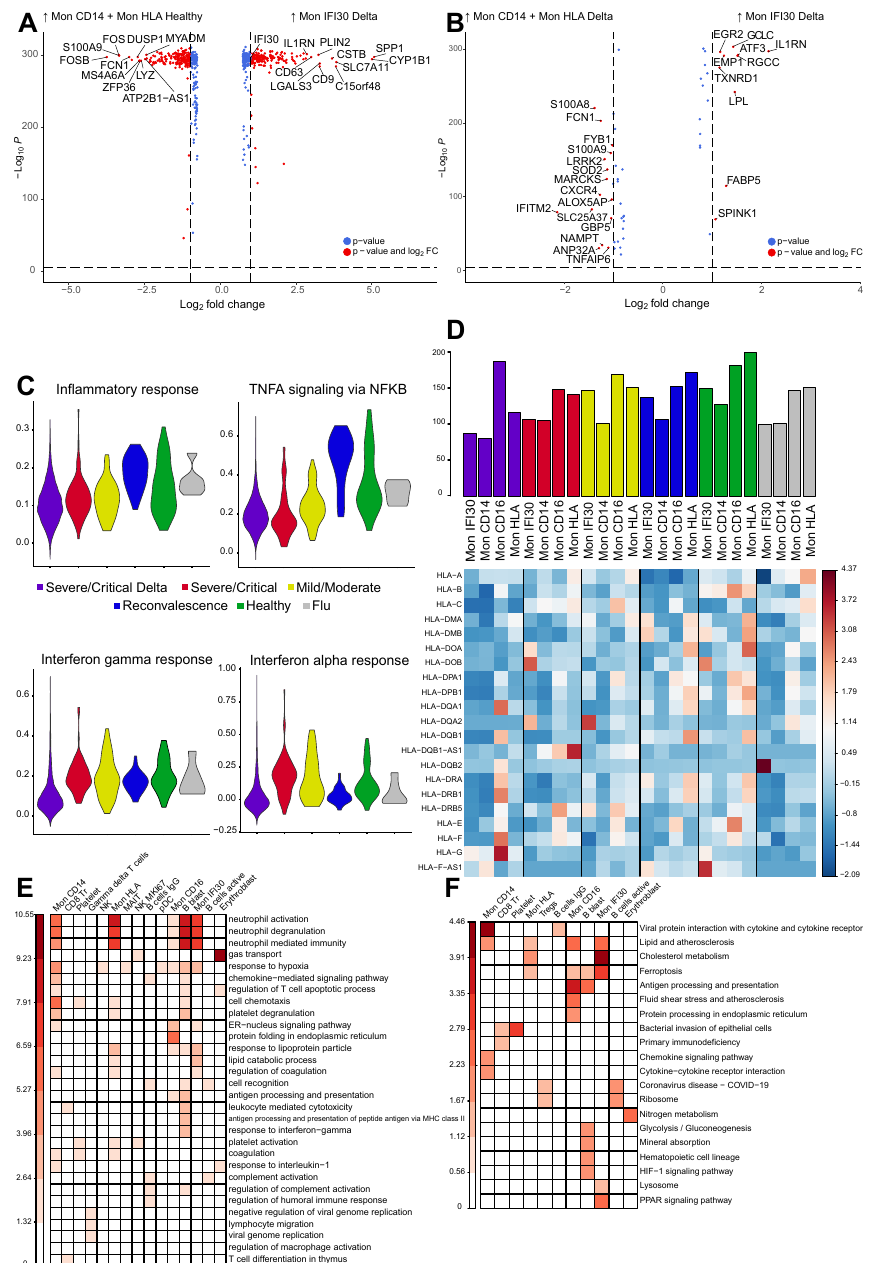
Figure 3. ( A ) Volcano plot showing gene expression changes between Mon IFI30 from severe Delta samples contrasted with Mon CD14 and Mon HLA from healthy groups because Mon IFI30 is enriched only in the severe Delta COVID-19. Only top significant markers with absolute logFC > 0.75 are highlighted. ( B ) Volcano plot showing gene expression aspects specific for Mon IFI30 contrasted with Mon CD14 and Mon HLA inside Delta samples and indicating gene activity heterogeneity in the myeloid PBMC group due to severe Delta COVID-19. Only top significant markers with absolute logFC > 0.75 are highlighted. ( C ) Violin plot with module scores for Inflammatory, TNF alpha, Interferon-gamma, and Interferon-alpha signatures for Mon IFI30 cells across study groups. ( D ) Heatmap with expression (z-score) of the HLA genes in monocytes across study groups. Bar plot with the summed expression of the HLA genes within a cell type in each cohorte. ( E ) Heatmap with enrichment of the Biological Processes and (F) KEGG pathways enriched in a set of upregulated ( p .adj < 0.05, logFC > 1.5) genes obtained in a pairwise cell subtype comparison between severe Delta and Wuhan-like